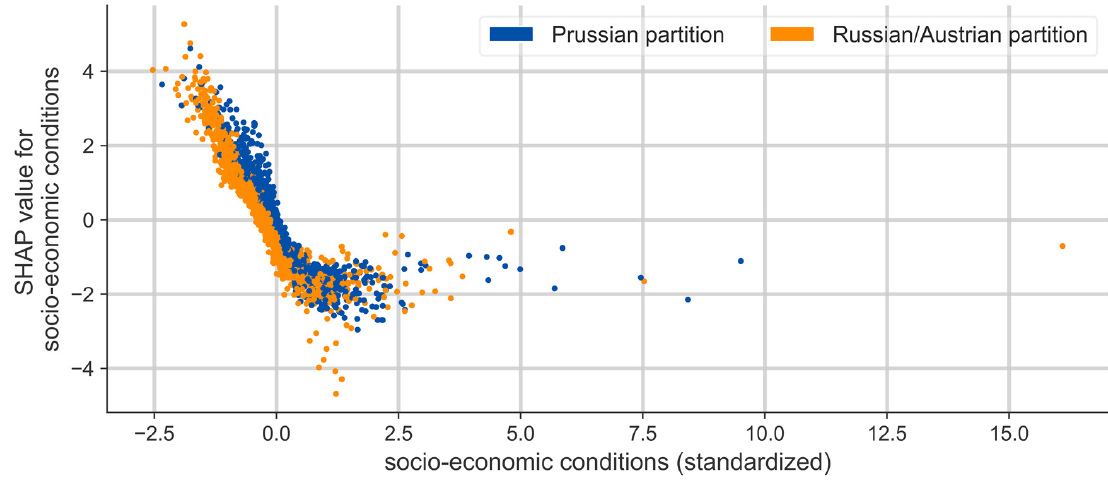
Figure 8. Shapley values for the variable presenting the level of socio-economic development. Source: developed by the authors, based on ARMA and CSO data.